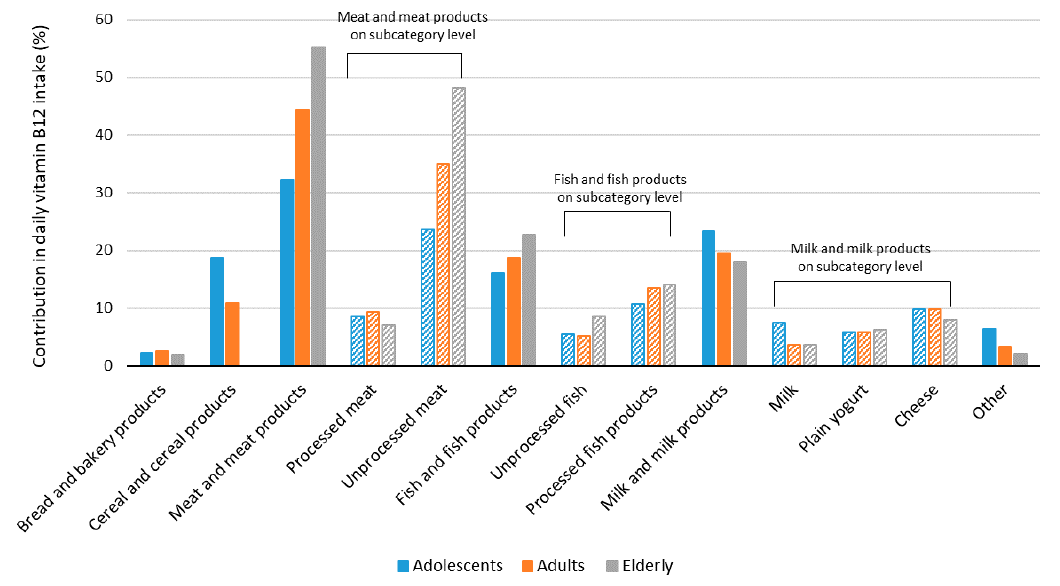
Figure 2. Relative contributions of selected food categories to usual daily vitamin B12 intake among different age groups (% of total vitamin B12 intake).